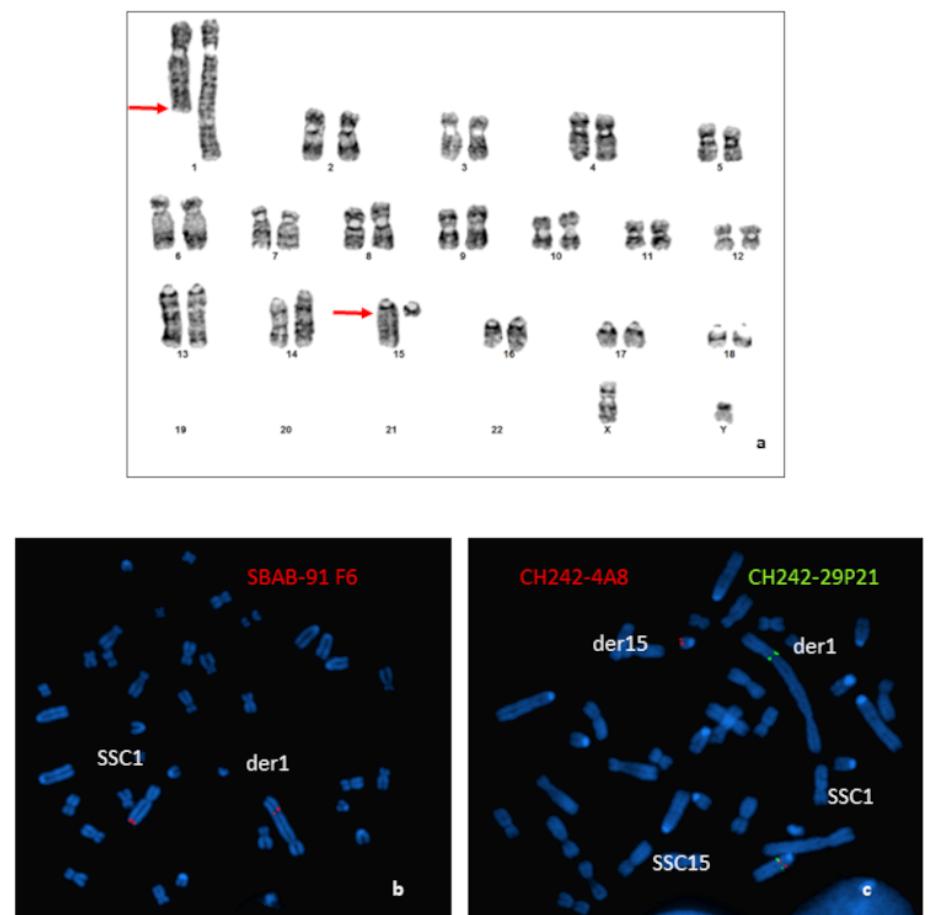
Figure 1. Characterization of the chromosomal rearrangement. ( a ) GTG-banded karyotype of the boar carrying a t(1;15)(q2.11;q1.2) translocation. Arrows indicate the locations of the breakpoints. ( b ) Localization of the breakpoints by FISH using BAC clones: ( b ) hybridization of the SBAB-91F6 (red); ( c ) hybridization of the CH242-4A8 (red); and CH242- 29P21 (green) BAC clones.